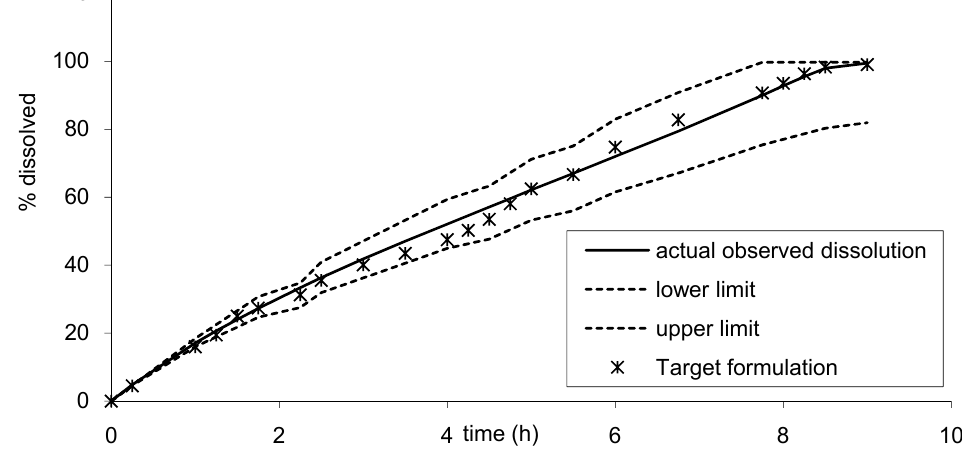
Figure 13. Dissolution on a target formulation derived from formulation B to ensure decrease of Cmax maintains a